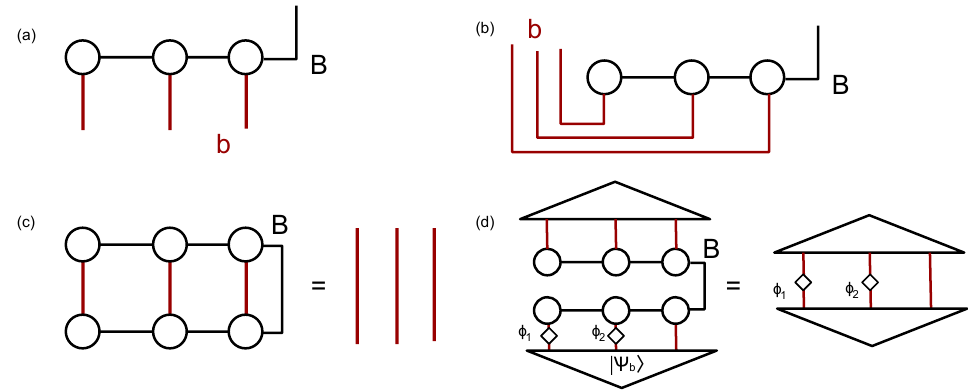
Figure 15. (a) A tensor network with bulk state (cid:26) b = j b i h b j . The red lines are bulk quantum (cid:12)eld theory degrees of freedom, and the black lines are EPR pair (geometry) degrees of freedom. (b) By leaving the b legs open, we can view the tensor network as a map from b to B , or equivalently, an entangled state of b and B . (c) The isometry condition is equivalent to the statement that in the state of b and B , tracing over B leads to a maximally mixed state of b . (d) The isometry condition implies that the bulk correlation functions are equal to those in